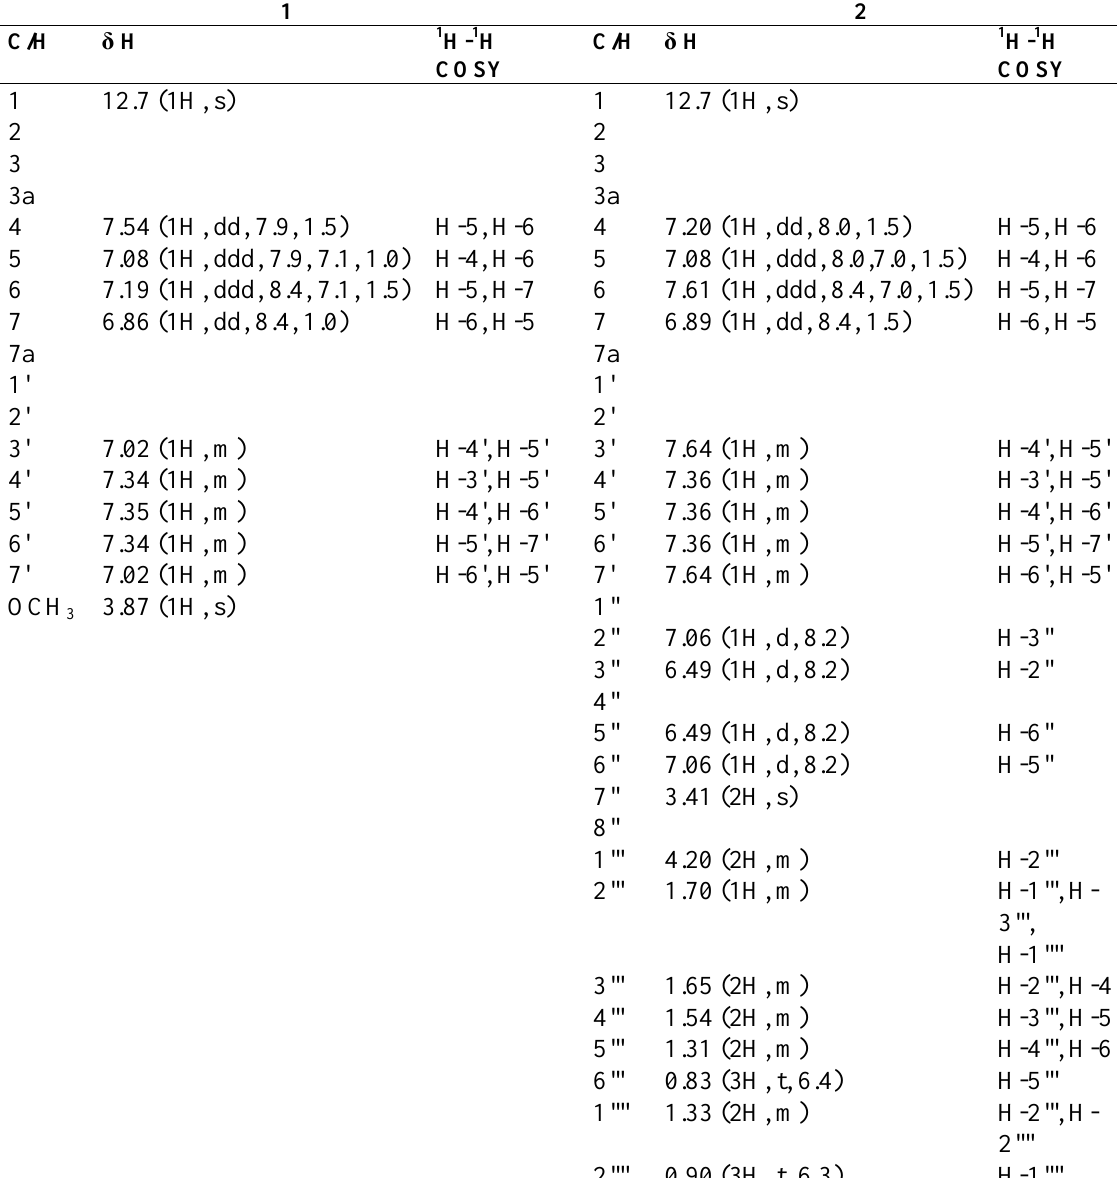
OD) of isatinone A ( 1 ) and isatinone B ( 2 3